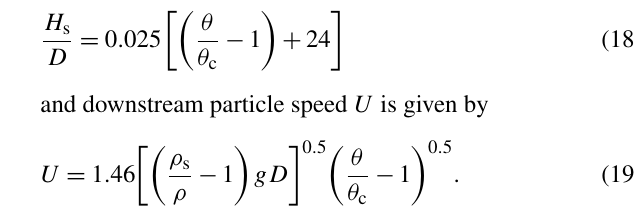
Figure 2. Schematic top view of a straight bedrock channel, with alternating submerged gravel bars (dark grey) on a bedrock bed (white). The sinuous thalweg (light grey) and bedload path (trans- parent dark grey) are indicated. The dashed black line indicates the cross section that is ideal for sideward deflection of particles; here, the bedload particle stream crosses the boundary between gravel and smooth bedload. The wavelength of the alternating bars and therefore of the bedload path should scale with channel width. Adapted from Turowski (2018).